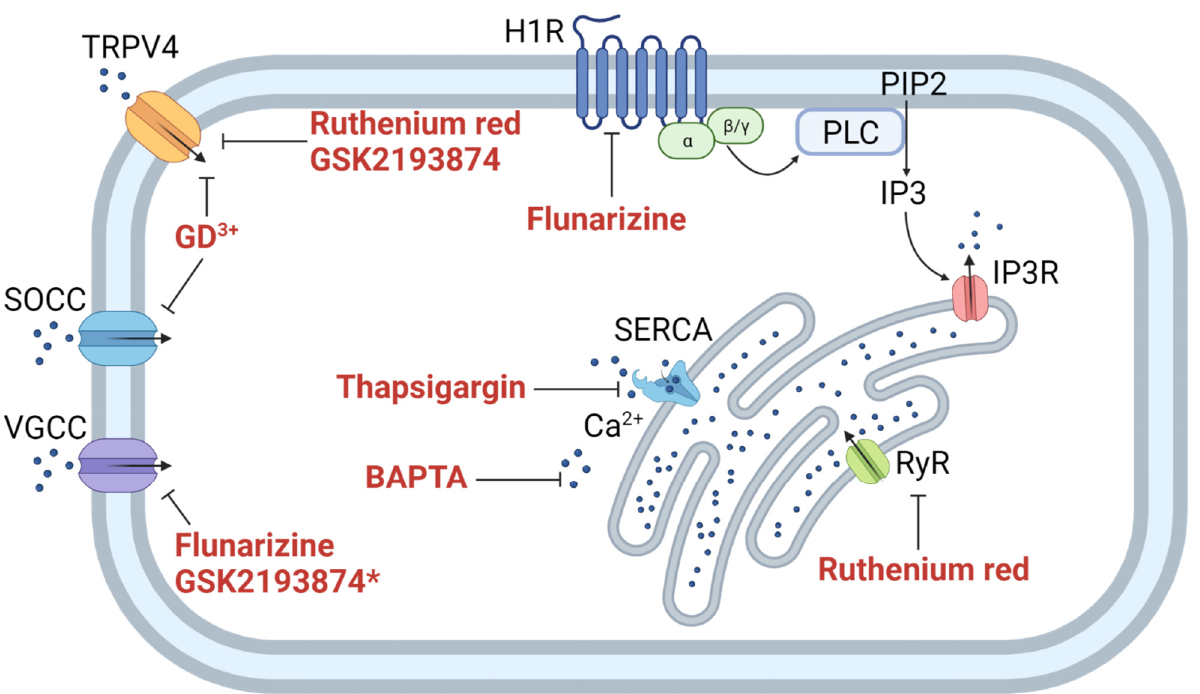
Figure 9. Transporters and receptors involved in calcium (Ca 2+ )-signalling and inhibitors used during the 75th ESA parabolic flight campaign. Blunted-head arrow show inhibiton of transporters and pumps by its associated drug, normal arrows show molecule movement through transporters or in signal cascades. H1R: Histamine H 1 receptor; IP3: Inositol trisphosphate; IP3R: Inositol trisphosphate receptor; PIP2: Phosphatidylinositol 4,5-bisphosphate; PLC: Phospholipase C; RyR: Ryanodine receptors; SERCA: Sarco/endoplasmic reticulum Ca 2+ -ATPase; SOCC: Store-operated Ca 2+ channel; TRPV4: Transient receptor potential cation channel subfamily V member 4; VGCC: Voltage-gated Ca 2+ channel. This figure was created with BioRender.com (accessed on 5 January 2022). Thapsigargin, a Sarco/endoplasmic reticulum Ca 2+ -ATPase (SERCA) inhibitor